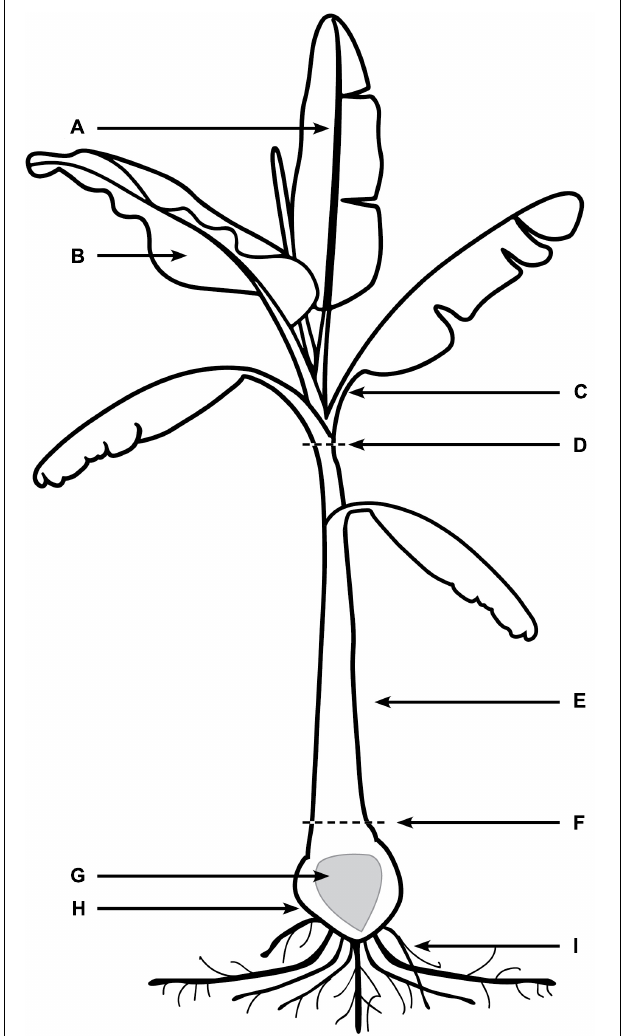
FIGURE 1 | Areas of banana plant used for observation of Foc GFP under confocal microscopy. (A) Midrib of leaf blade. (B) The leaf blade. (C) Petiole of the leaf blade. (D) Throat of the plant (area of new leaf emergence. (E) Leaf sheaths of the pseudostem, including attached senescing sheaths. (F) Area of pseudostem emergence above the soil. (G) Central cylinder of rhizome. (H) Cortex of rhizome. (I) Roots including rot tips and sections close to